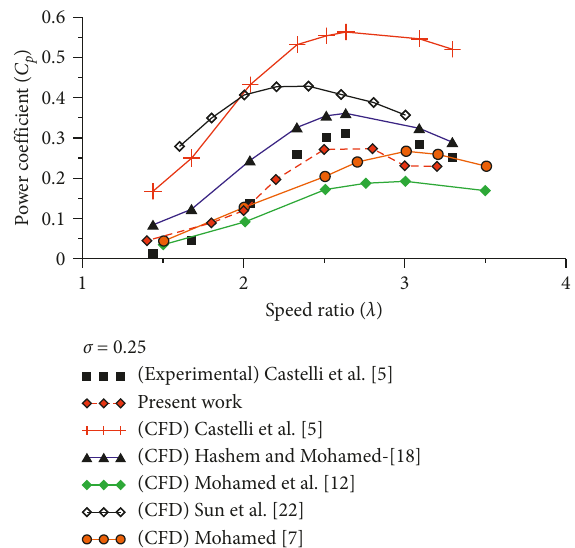
Figure 9: Present CFD study versus the experimental results of [5] and other CFD results for a Darrieus turbines [5, 7, 12, 18,